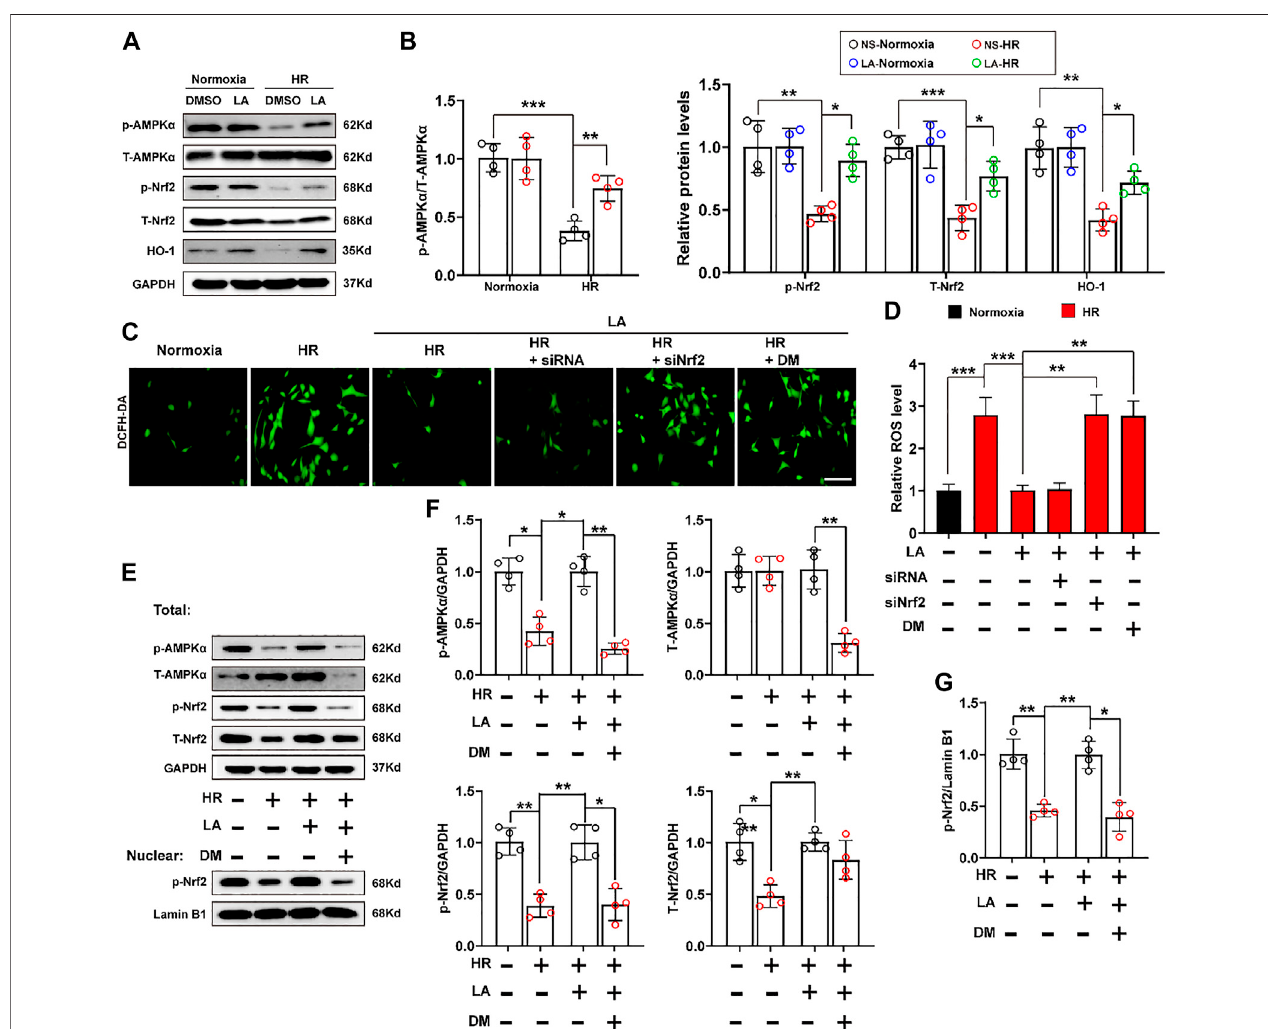
FIGURE 7| LA-mediated activation of Nrf2/HO-1 pathway depends on phosphorylation of AMPK α . Nrf2 siRNA and dorsomorphin, an inhibitor of AMPK α , LA and DMSO pretreated H9C2cellsweresubjectedtoHRorNormoxia (A,B) .Representativewesternblotandanalysisofp-AMPK α ,AMPK α , p -Nrf2,Nrf2andHO-1 inH9C2 cells, normalized to GAPDH ( n (cid:1) 4) (C,D) . Representative ROS levels of H9C2 cells were measured by incubating with DCFH-DA probe, and then analysis fl uorescence intensity, Scar bar: 50 μ m (E,G) . (E) and (F) . Representative western blot and analysis of p- AMPK α , AMPK α , p -Nrf2, Nrf2 and HO-1 in H9C2 cells, normalized to GAPDH ( n (cid:1) 4). (E) and (G) . Representative western blot and analysis of p -Nrf2 in nuclear from H9C2 cells, normalized to Lamin B1 ( n (cid:1) 4). Data are presented as the mean ± SEM, with each point representing a mouse or a cell sample. * indicates p < 0.05, ** indicates p < 0.01, *** indicates p <